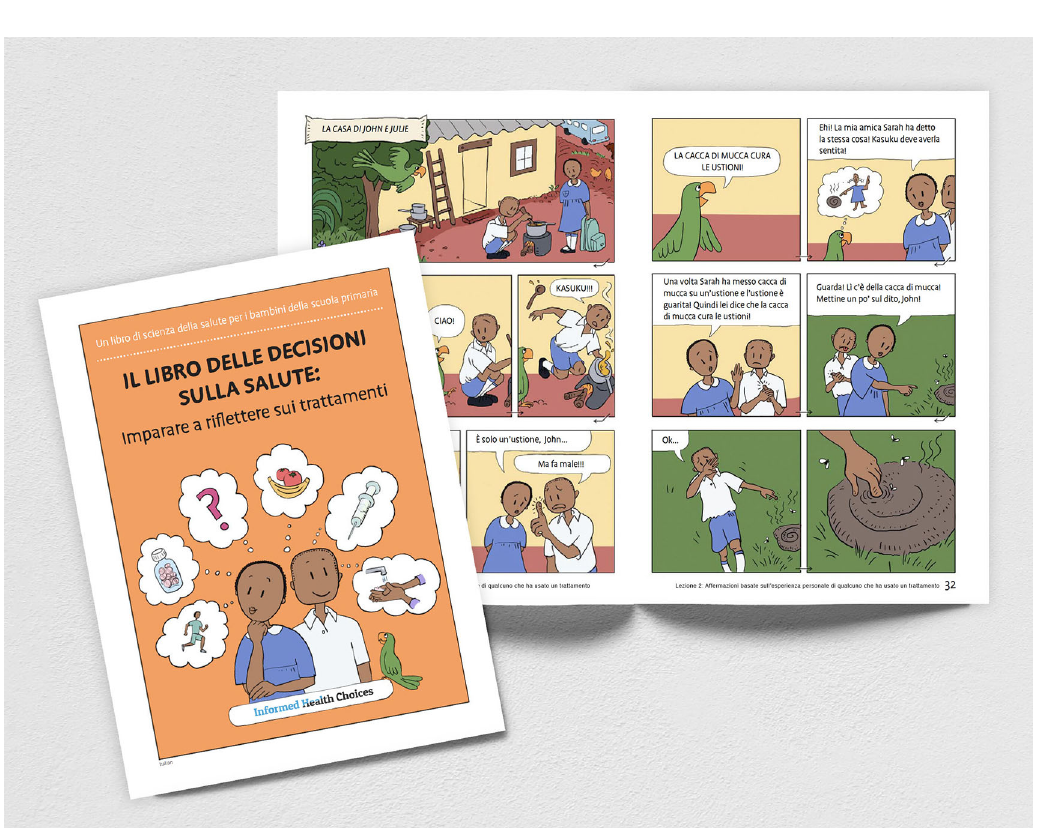
Figure 1. Italian translation of “ The Health Choices Book: Learning to think carefully about treatments ” for primary school